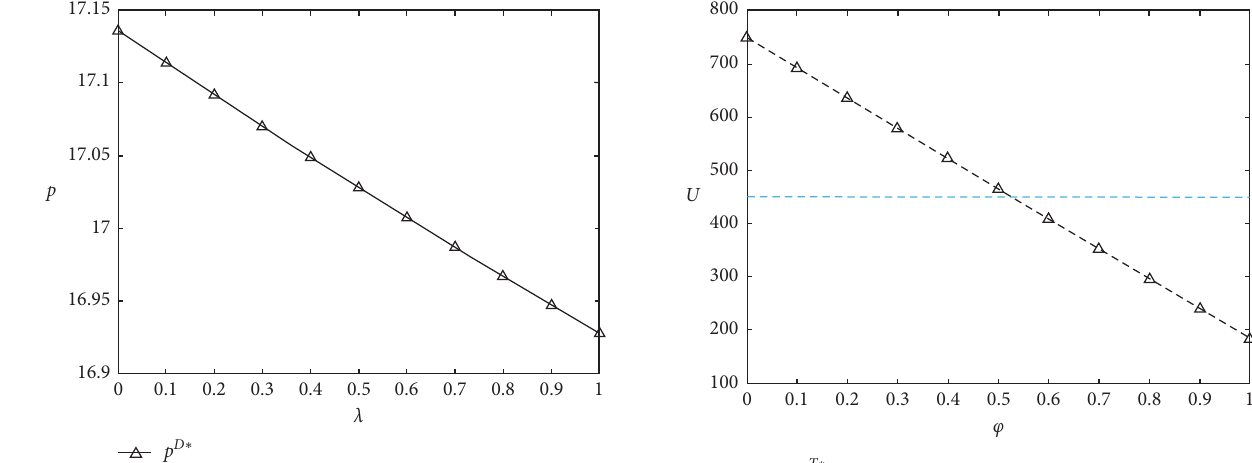
Figure 5: The effect of risk aversion coefficient on sales price.